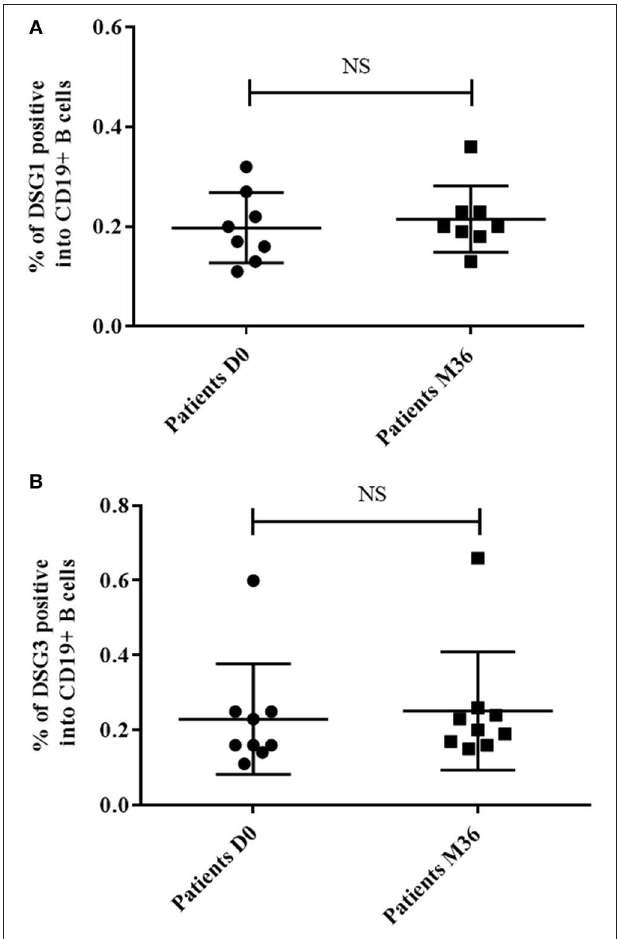
FIGURE 2 | Percentage of autoreactive DSG1-positive B cells (CD19 + DSG1 + ) (A) and DSG3-positive B cells (CD19 + DSG3 + ) (B) among total B cells (CD19 + ) collected in pemphigus patients at baseline and at Month 36 after rituximab treatment. Means ± standard deviations were compared using the Wilcoxon paired test.